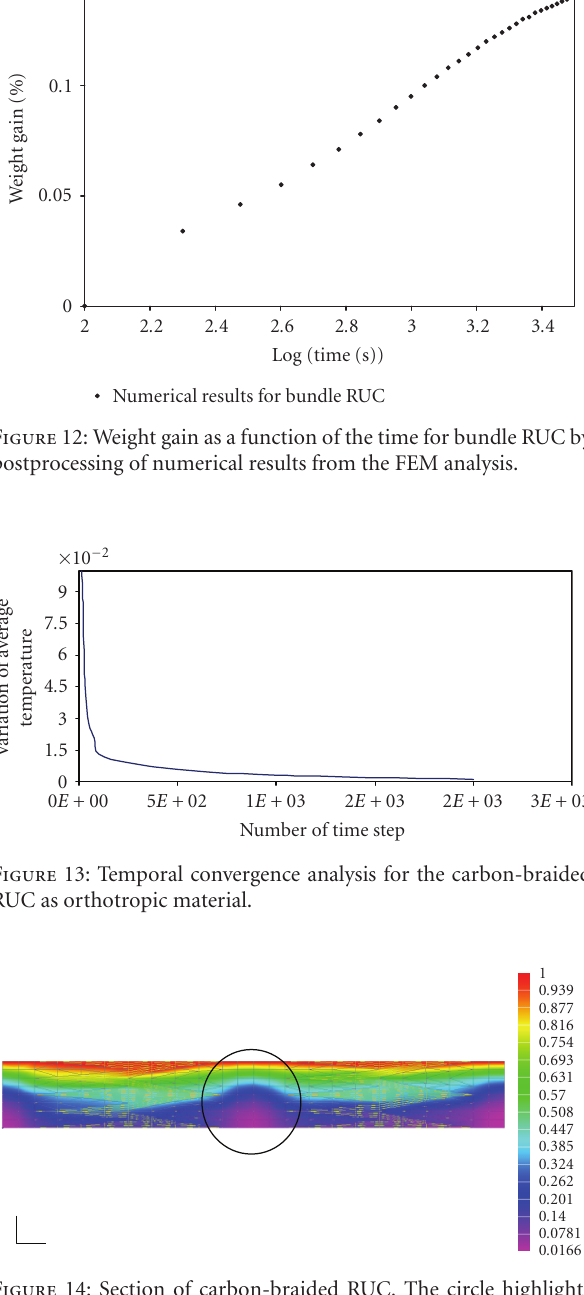
Figure 14: Section of carbon-braided RUC. The circle highlights the gradient of concentration through the thickness of the braided RUC considering the tows as isotropic